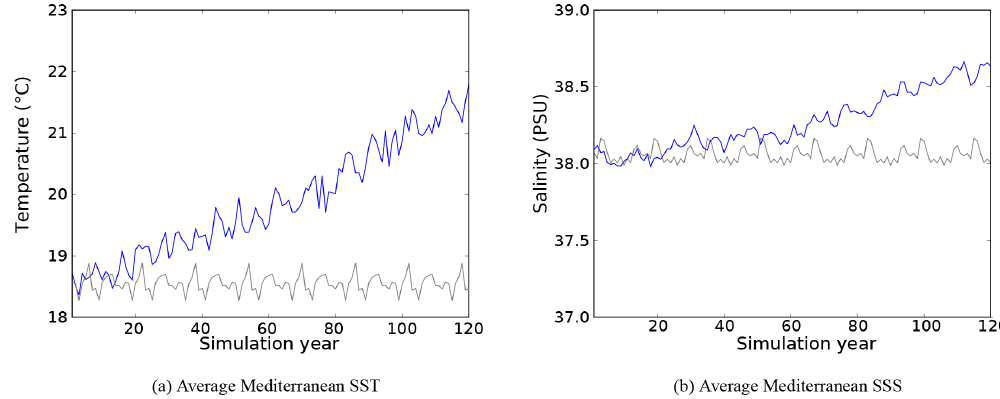
Figure 3. Evolution of average Mediterranean SST (a) and SSS (b) in the CTRL (grey) and HIS/A2 (blue)